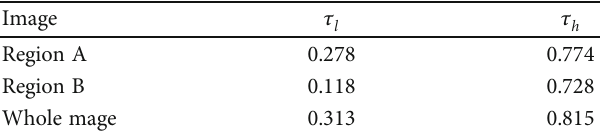
, τ of di ff erent l h